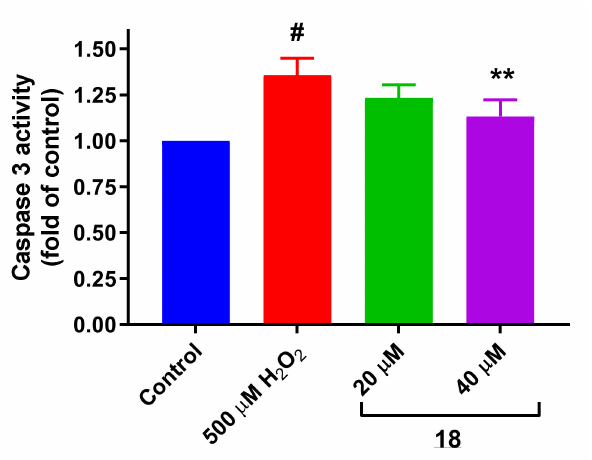
Figure 20. Reduction in caspase-3 activity by compound 18 in SH-SY5Y cells. Cells were treated with 18 at 0, 20, and 40 µ M for 24 h at 37 ◦ and then with H 2 O 2 500 µ M for 4 h. Data are presented as the Mean ± SEM of three different experiments carried out in quadruplicate. # p <0.001 vs. vehicle-treated control. ** p < 0.01 vs. only with H 2 O 2 -treated